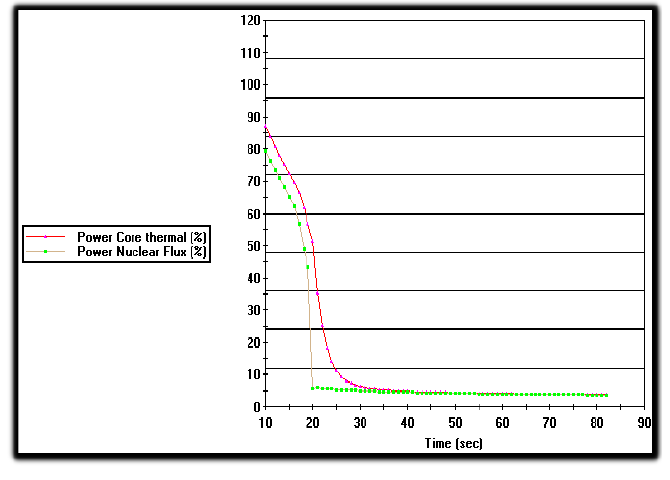
Fig. 16. Transient thermal and nuclear powers under turbine trip with pressure control system available at 100% RP